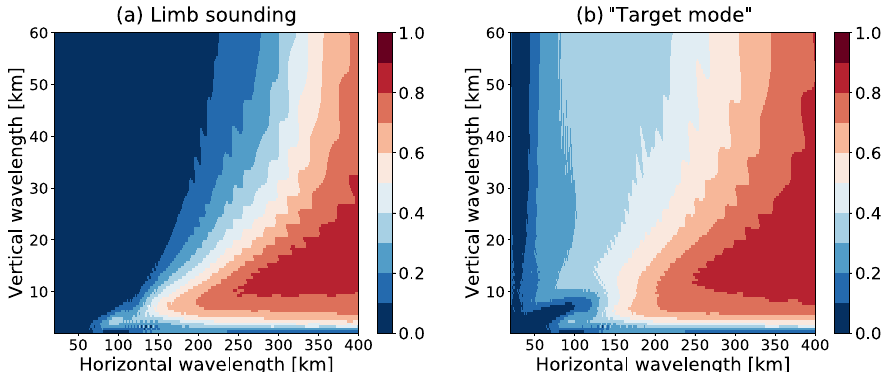
Figure 9. GW sensitivity function. The ratio of retrieved wave amplitude to true wave amplitude as function of horizontal and vertical wavelength is shown. Panel (a) is the sensitivity function for pure limb measurements, while panel (b) is for “target mode” measurements as specified in Sect. 5.